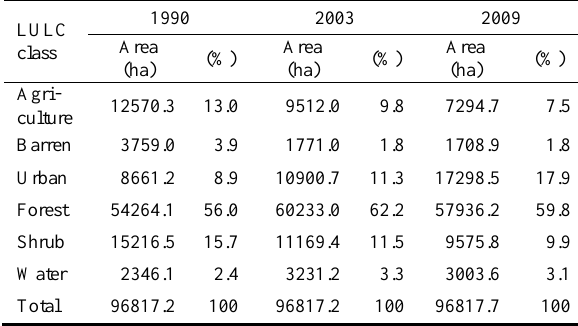
Table 3. Results of and use/cover classification for 1990, 2003 and 2009